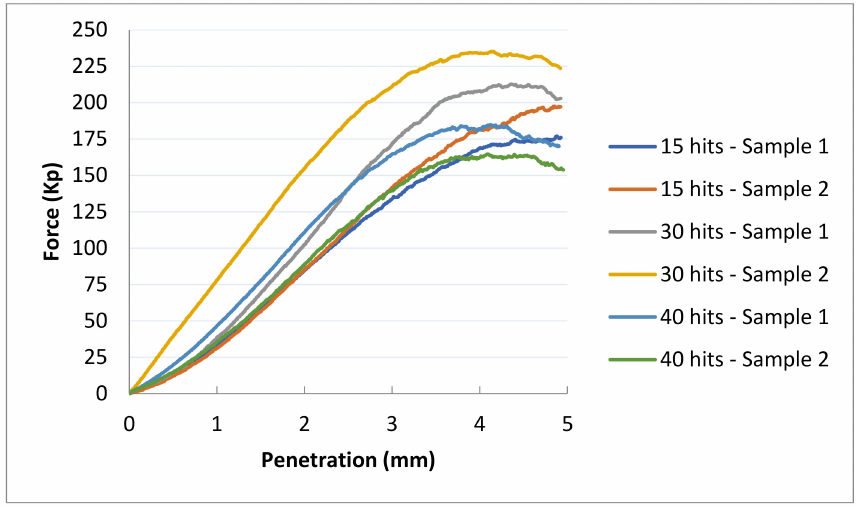
Figure 9. CBR test using each compaction (15, 30, and 45 hits).